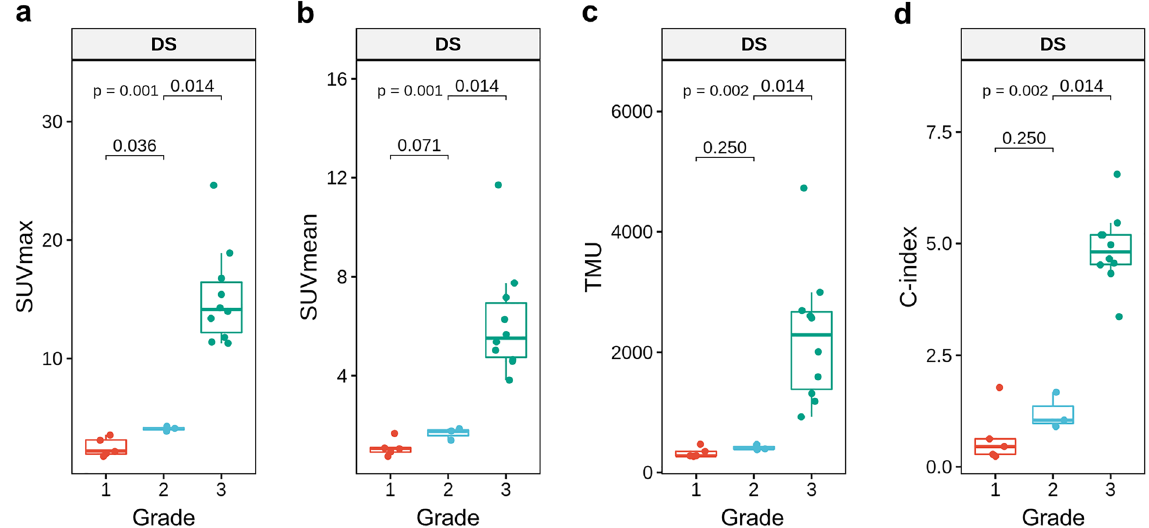
Figure 3. SPECT/CT indexes according to the visual grade, DS. SUVmax was significantly different between DS 1/2, and between 2/3 ( a ), whereas other indexes were not ( b–d